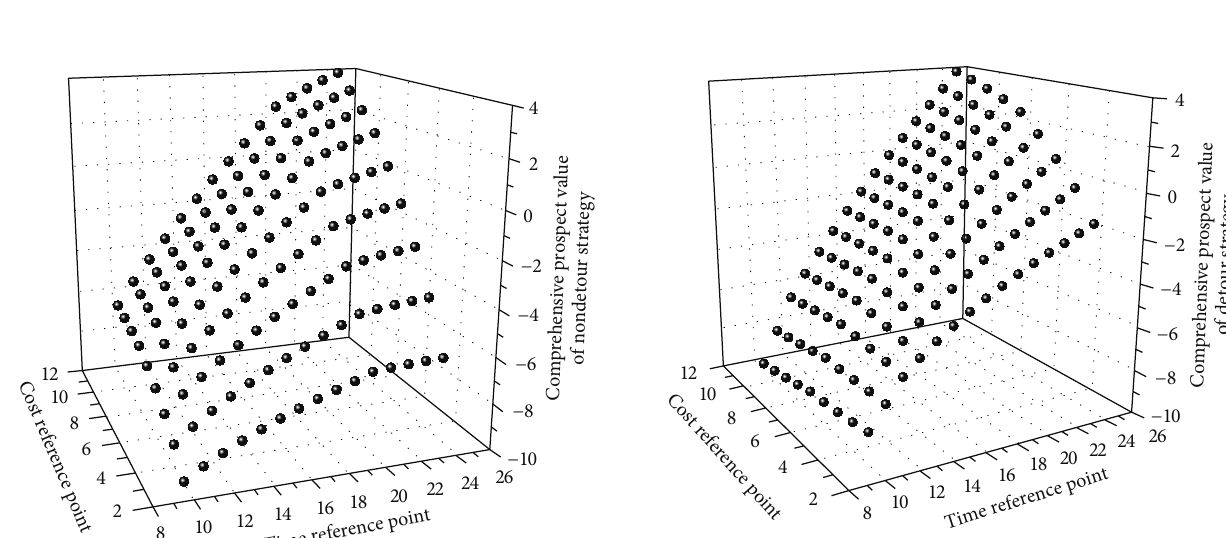
Figure 3: Strategies dynamic evolution of different initial probabilities.